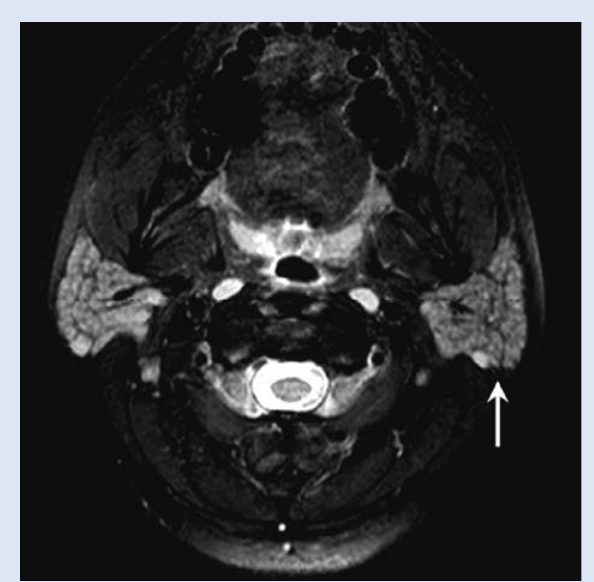
Fig. 2. Axial T2W fat-suppressed image (TE 60 ms, TR 3 000 ms) acquired with standard 4 mm-thick T2 fat-suppressed protocols for deep face and salivary gland. Microcysts are not differentiated from the glandular tissues.